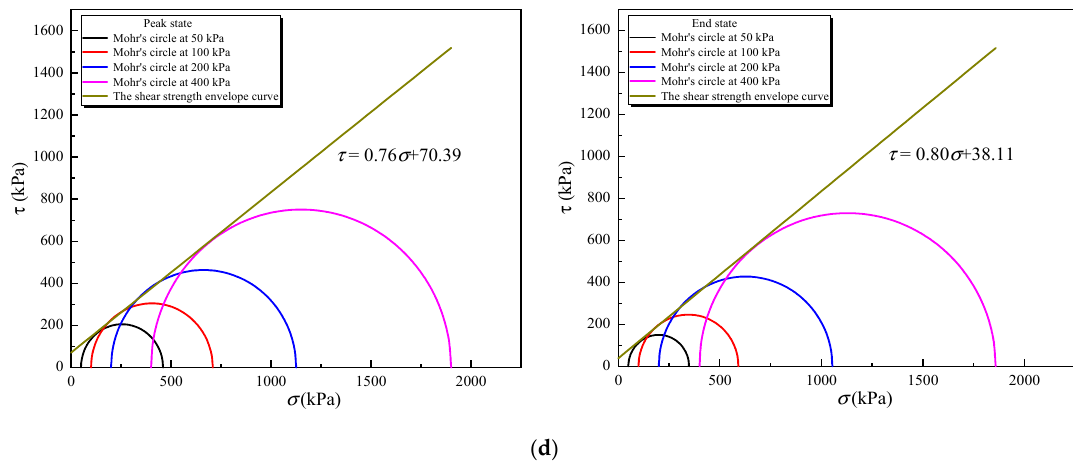
Figure 5. The shear strength envelope curves of coral gravelly sand under different stress states and water contents: ( a ) ω = 6%, ( b ) ω = 12%, ( c ) ω = 18%, ( d ) ω = 24%.